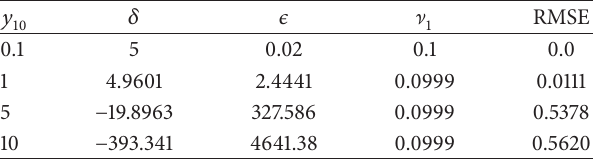
Table 1: Comparison of the numerical integration solutions of the equivalent and the original equations of motion for the parameter values 𝛼 = 5 , 𝛽 = 2 , 𝛾 = 0.5 , ] = 0.1 , 𝜎 = 0.94 , and 𝜐 = 100, 000 .